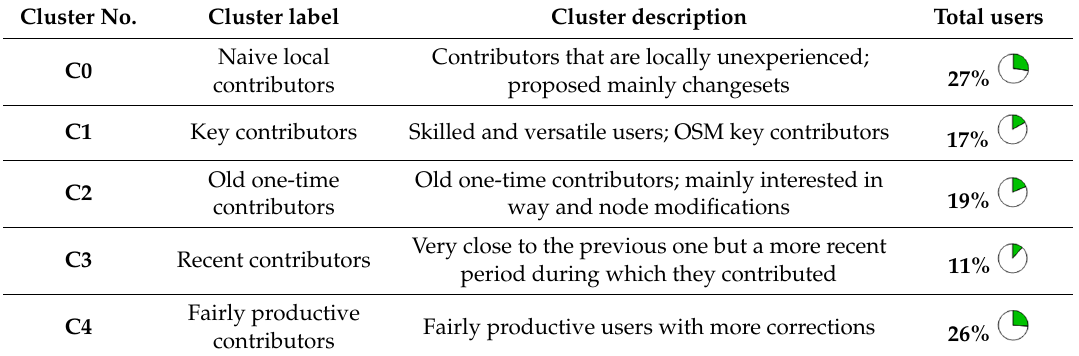
Table 2. User proficiency level clusters based on contribution behavior. OSM—OpenStreetMap. Cluster No.